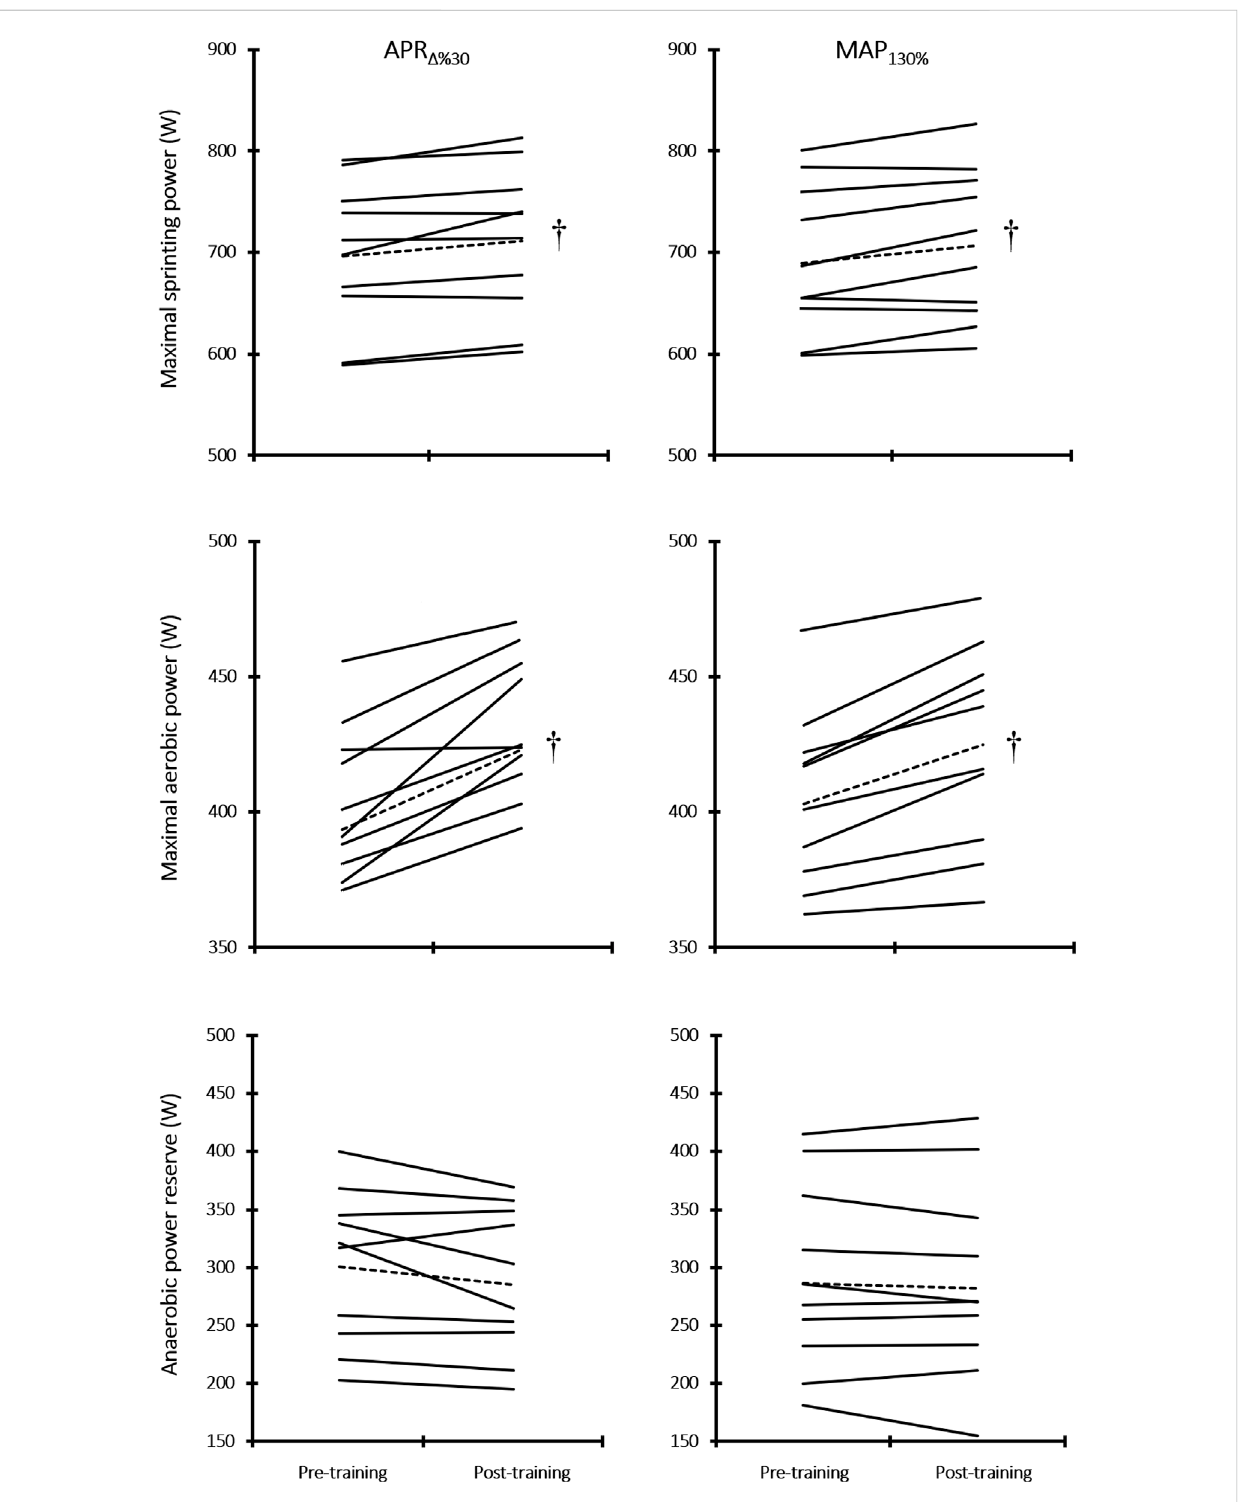
FIGURE 4 Individual changes in maximal aerobic power (MAP), maximal sprinting power (MSP), and anaerobic power reserve (APR) after the training period. † Denotes Signi fi cantly different versus pre-training ( p ≤ 0.05).